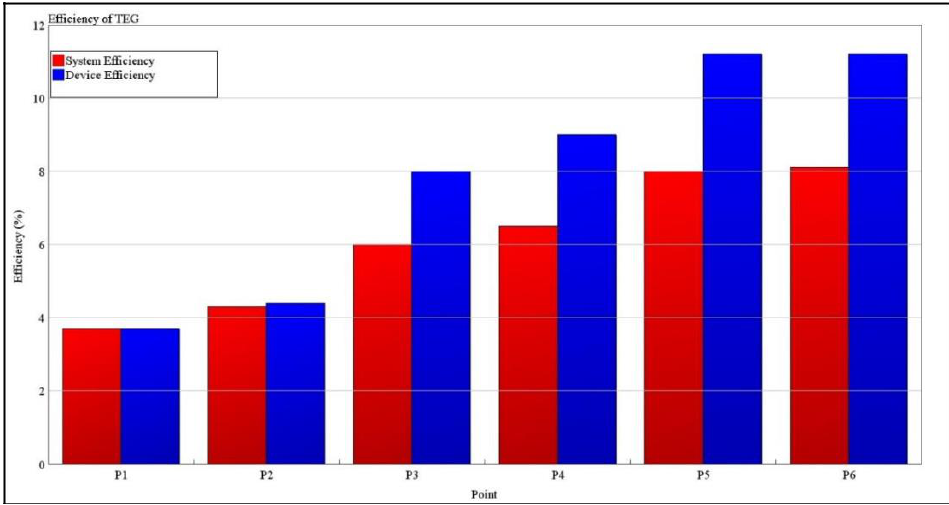
Table 4. Engine operating point for TEG.